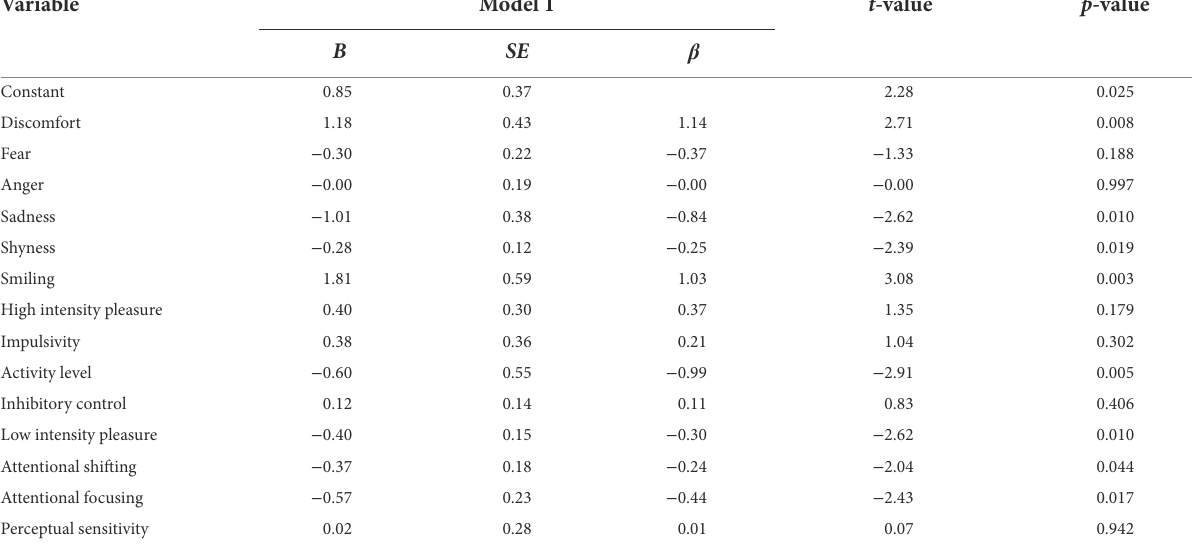
TABLE 5 Hierarchical regression coefficients for child temperament and child-teacher conflict.